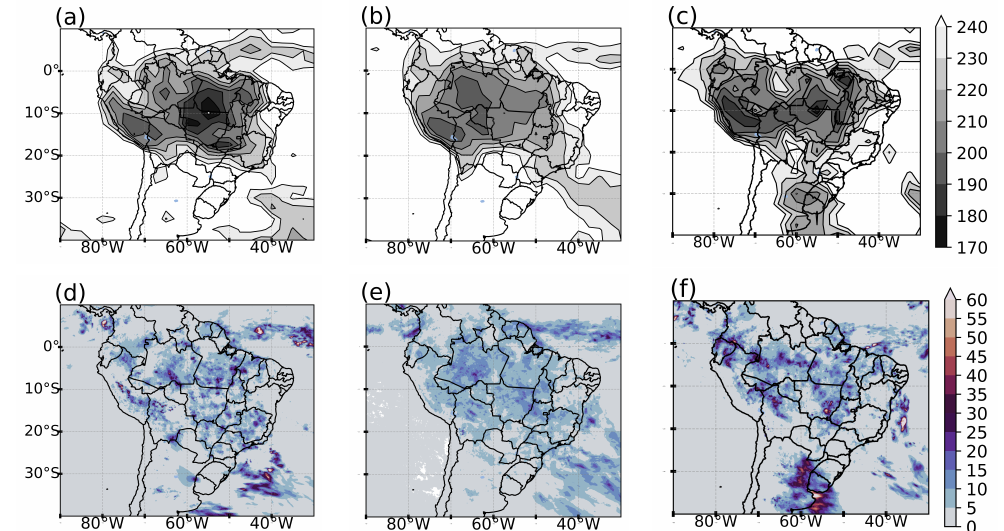
Figure 7. Main characteristics of the OLR (W · m − 2 ) ( a – c ) and precipitation (mm · day − 1 ) ( d – f ) for the − 3D (left), 0D (center), and +2D (right) panels of the SACZ events during the transition phase of the